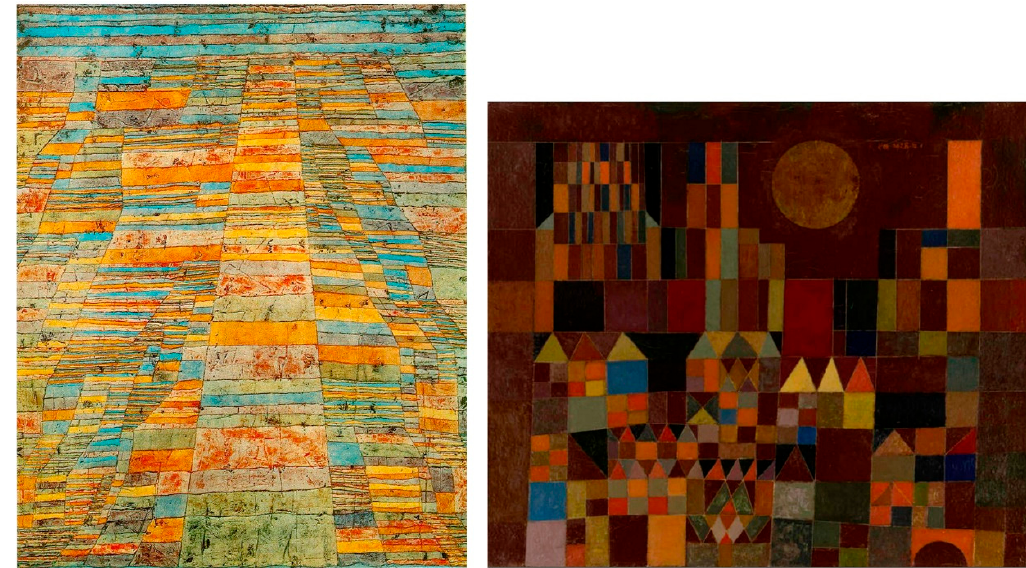
Figure 2. Highway and Byways by Paul Klee, 1929. Right: Castle and Sun by Paul Klee, 1928. Public domain images.